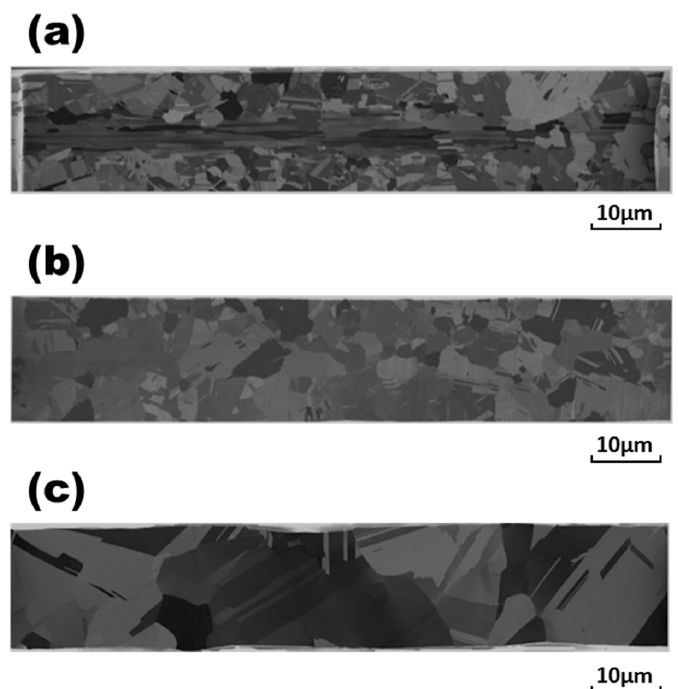
Figure 4. FIB image shows the grain structures in longitudinal cross ‐ sections of the Ag ‐ 3Pd wire after current stressing at 1.23 × 10 5 A/cm 2 for various times: ( a ) original; ( b ) 1 h; ( c ) 20 h.